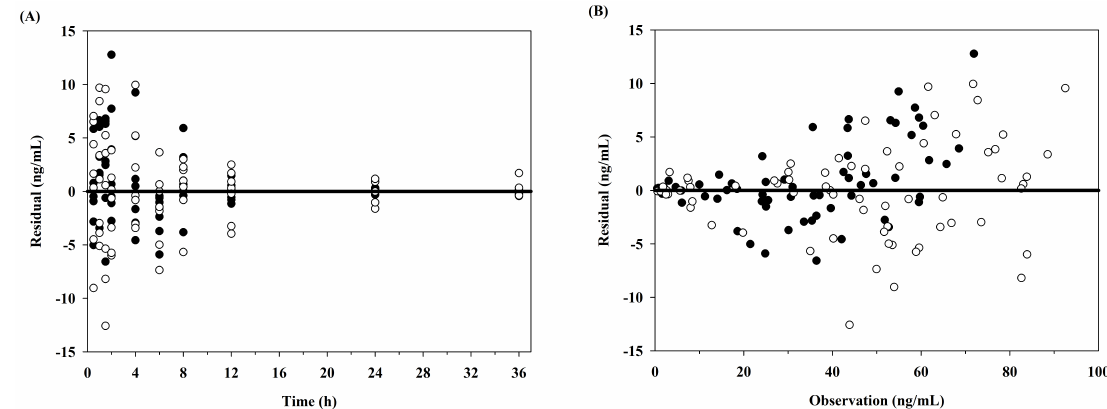
Figure 2. Diagnostic plots obtained from the final pharmacokinetic model of tadalafil after oral (closed circles) and intranasal administration (open circles) in dogs. ( A ) Residuals versus time after dose; ( B ) residuals versus observed concentrations. Table 2. Pharmacokinetic parameters for tadalafil estimated using a one-compartment model with first-order absorption and elimination constants for both the oral and intranasal administration of 5 mg tadalafil to dogs. Data are presented as mean ± standard deviation (SD).